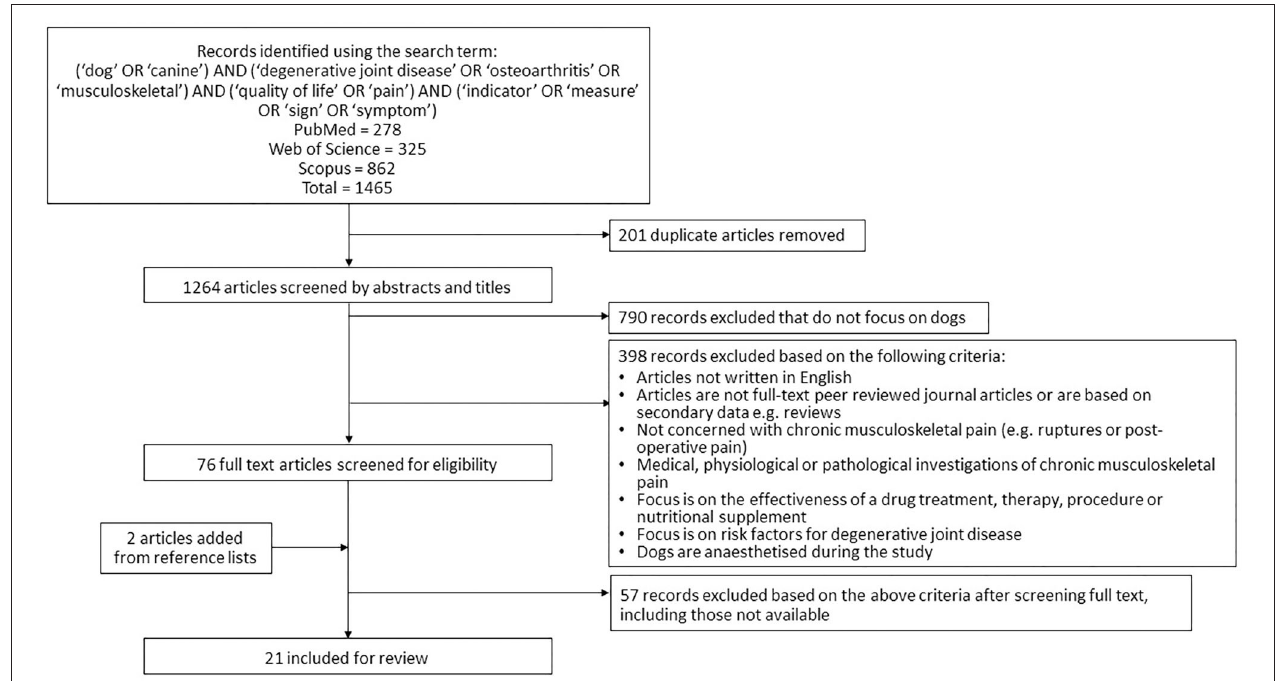
FIGURE 1 | Flow diagram summarizing the literature search on canine osteoarthritis and application of eligibility criteria.